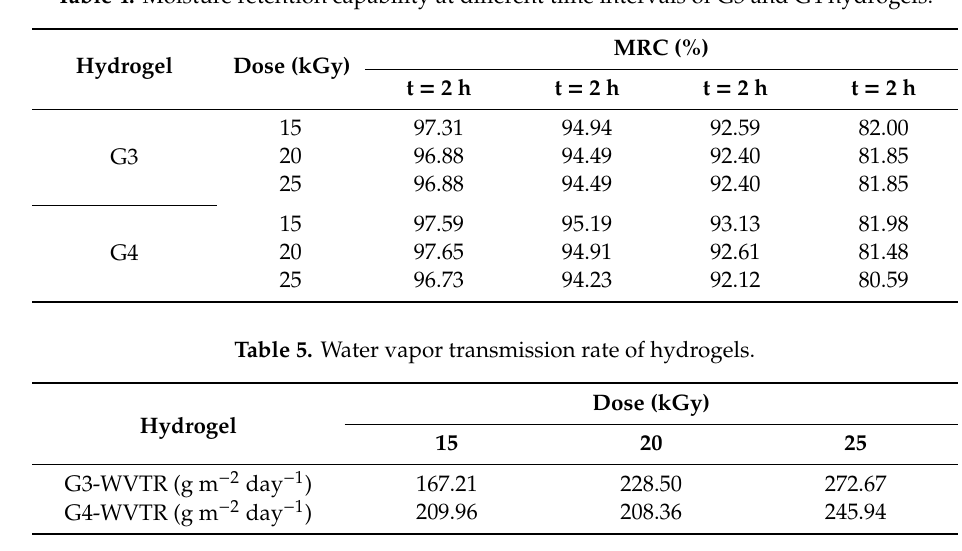
Table 4. Moisture retention capability at di ff erent time intervals of G3 and G4 hydrogels.